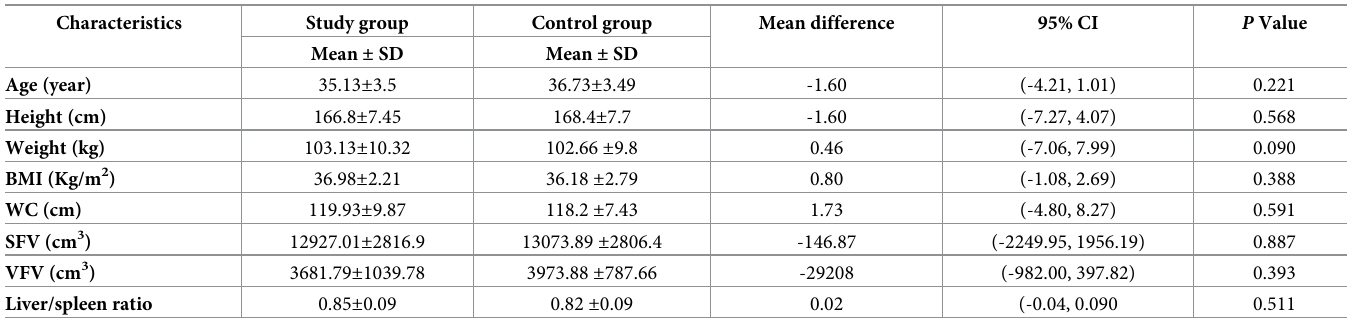
Table 1. Baseline demographic and clinical characteristics of patients. Characteristics